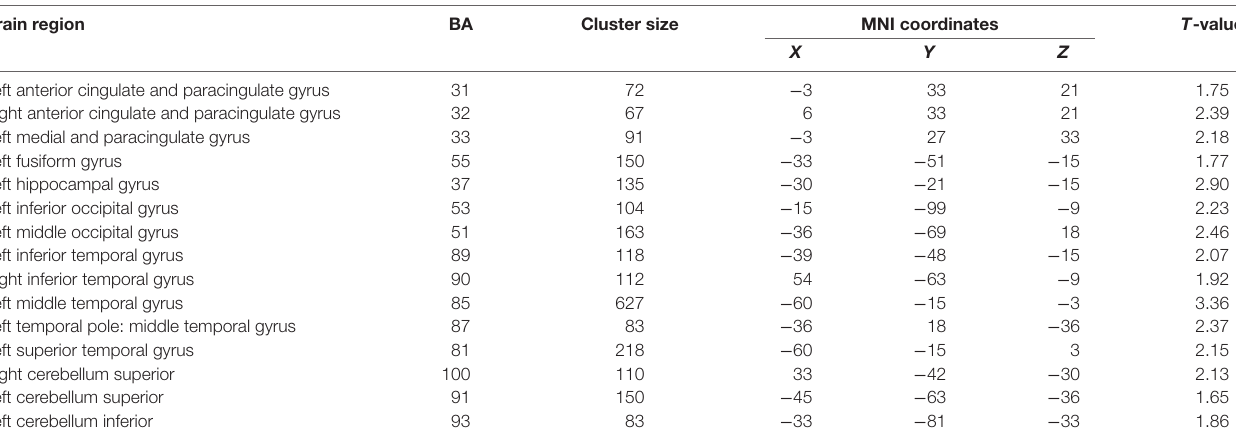
TABLE 2 | Brain regions showing significant differences in dFCD variability among the two